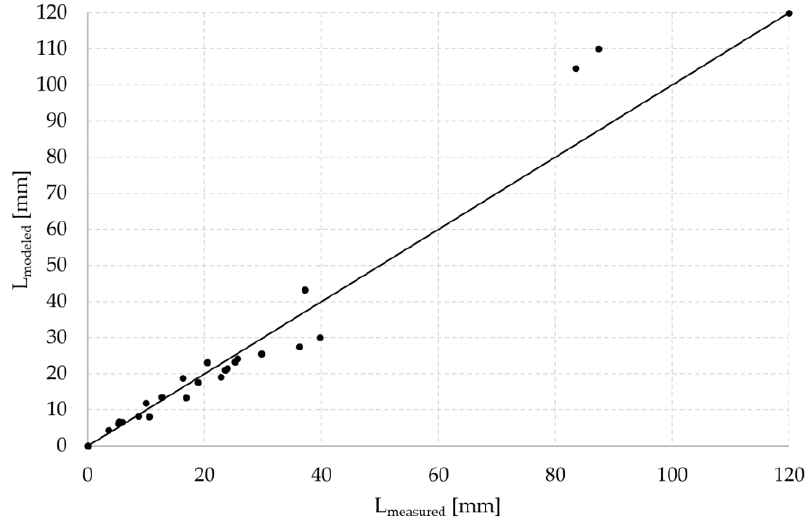
Figure 14. Cavitation model for existing hydrofoil, coefficient of determination R 2 = 0.9586.